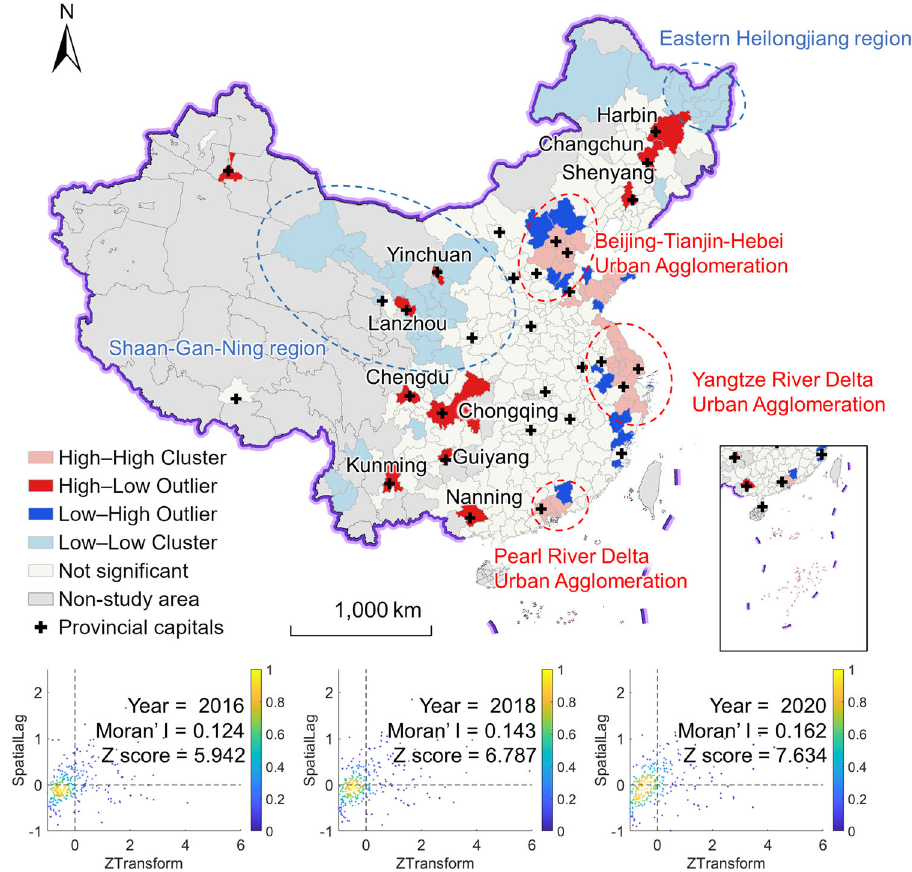
Fig. 4 Spatial autocorrelation analysis of the pseudo-human settlements index (PHSI). The upper and lower parts of the fi gure, respectively, show the spatial distribution map and scatter diagram of local spatial autocorrelation analysis of PHSI, where the High – High cluster implies that the PHSI of the city and surrounding cities is high (statistically signi fi cant) (located in the fi rst quadrant of the scatter map); Low – High outlier means that the PHSI of the city is low while that of its surrounding cities is high (located in the second quadrant of the scatter diagram); Low – Low cluster means that the PHSI of the city and surrounding cities is low (located in the third quadrant of scatter diagram); High – Low outlier represents the PHSI of the city itself is high while that of its surrounding cities is low (located in the fourth quadrant of the scatter diagram). The map was developed by the authors using ArcGIS Pro Version 3.0.2, and the background map was issued by the Ministry of Natural Resources of the People ’ s Republic of China (drawing review No. GS (2020) 4619), as shown in the website: